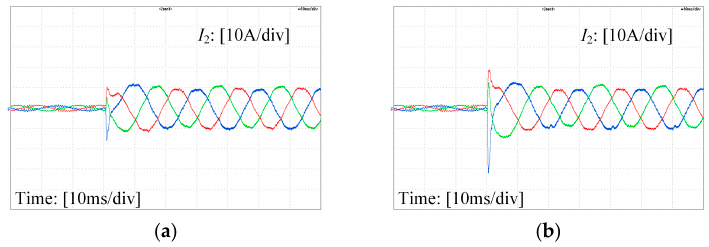
Figure 20. Grid-connected converter starting in rectifier mode with SCVDFF when grid inductance L ’g = 0. ( a ) K 1 f = 0, K 2 f = 0.75; ( b ) K 1 f = 0, K 2 f = 0.25.